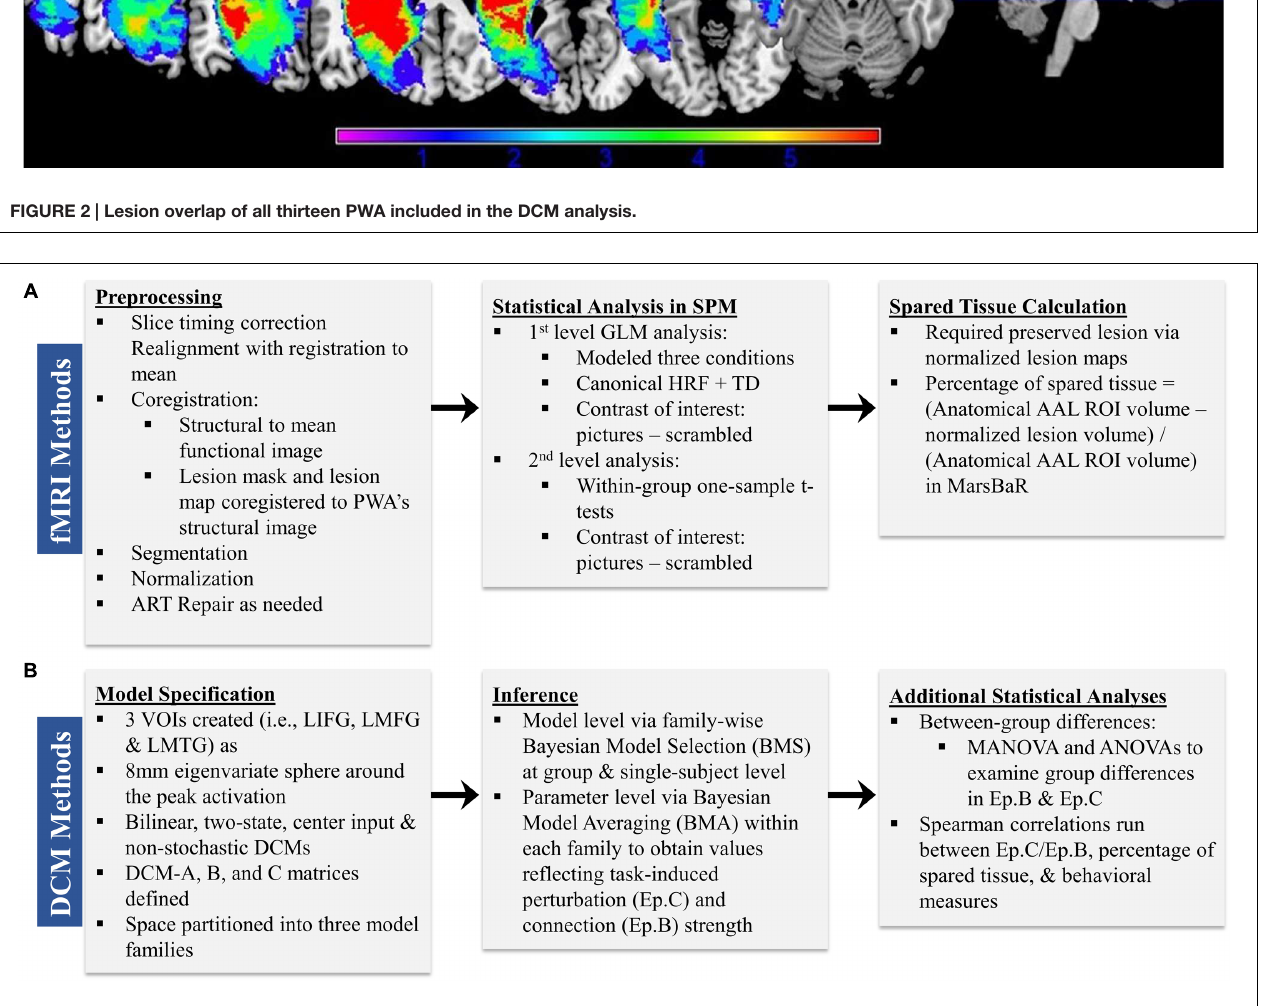
FIGURE 3 | Overview of the sequence of (A) fMRI and (B) DCM